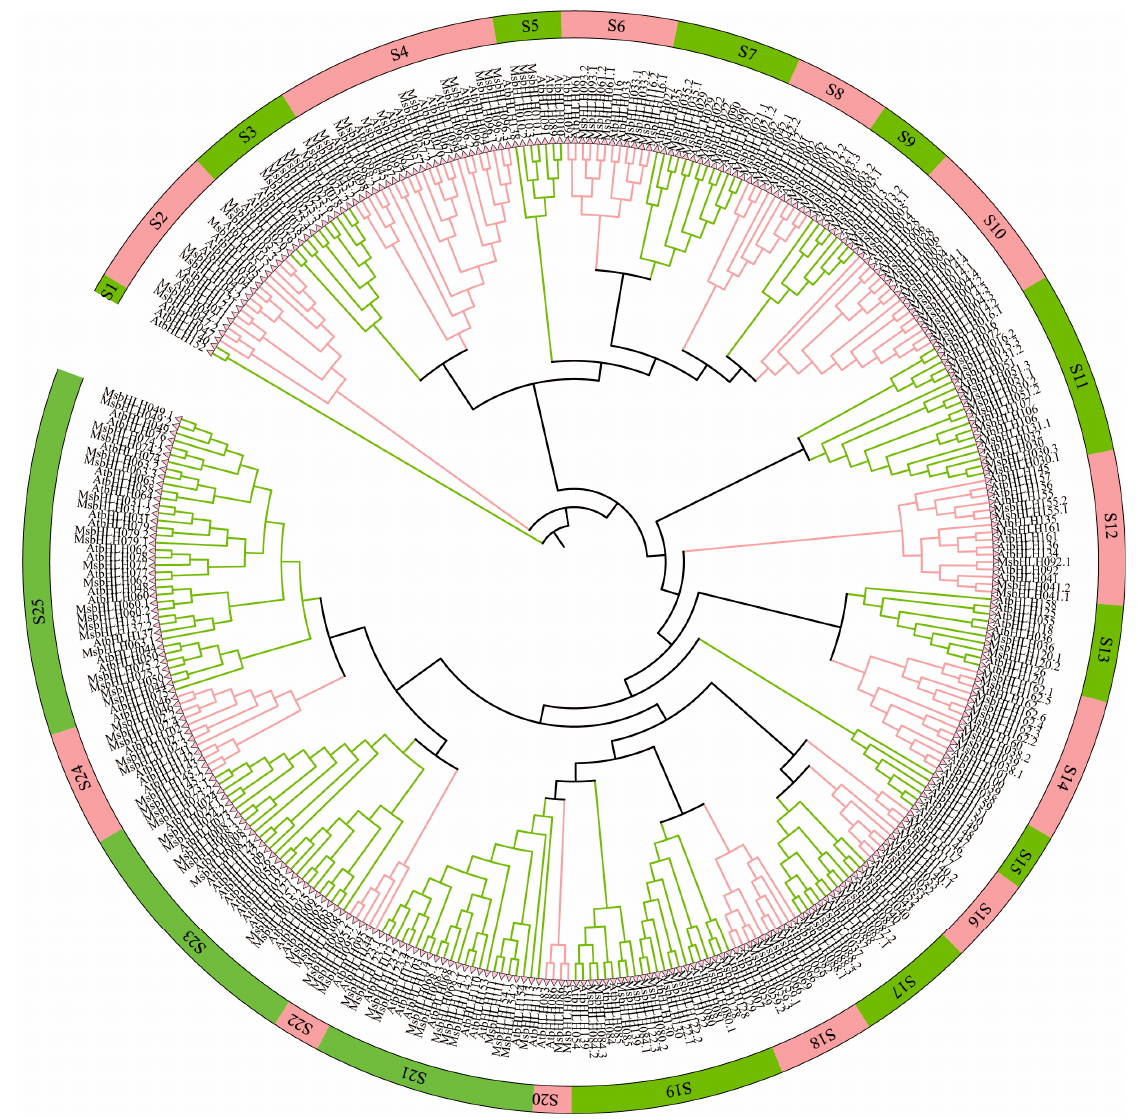
Figure 2. Phylogenetic tree of M. sieversii and A. thaliana. Phylogenetic tree constructed from the neighbor-joining method using the bHLH transcription factor domain for M. sieversii. MEGA 6.0 software to obtain a tree using the neighbor-joining method with a bootstrap of 1000 replicates. S1– S25 represent subfamily 1–subfamily 25.